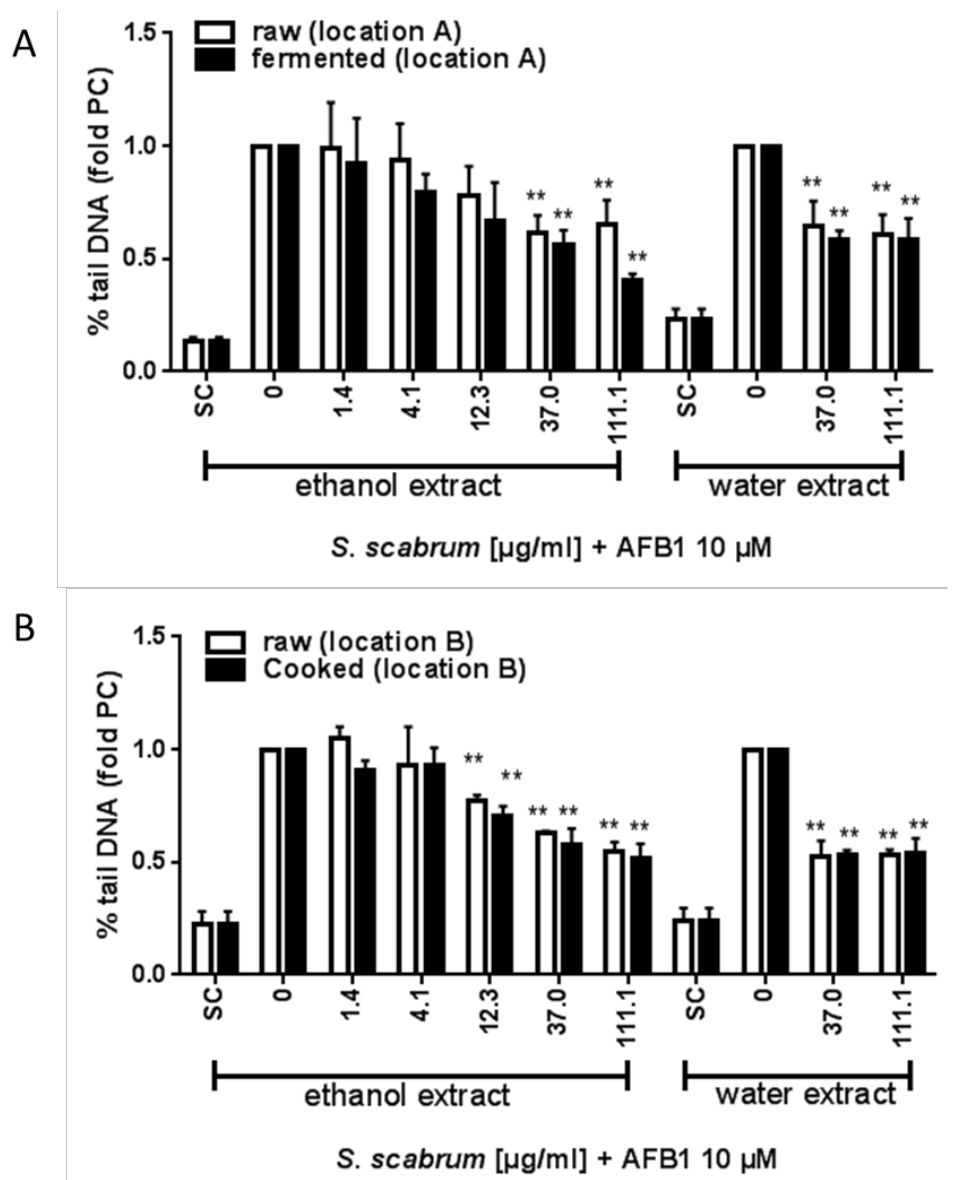
Figure 2. Anti-genotoxic activity of raw and processed S. scabrum . Results derived from the Comet assay are shown as percent tail DNA ( A , B ) calculated relative to AFB 1 -treated cells. SC: solvent control, 0.1% DMSO + 0.7% ethanol (for ethanolic extracts) or 0.1% DMSO + ddH 2 O (for water extracts). Data are means ± SEM of three independent experiments. Asterisks indicate statistically significant differences between the respective treatment and the positive control (without S. scabrum leaf extract) p ≤ 0.01 (**).